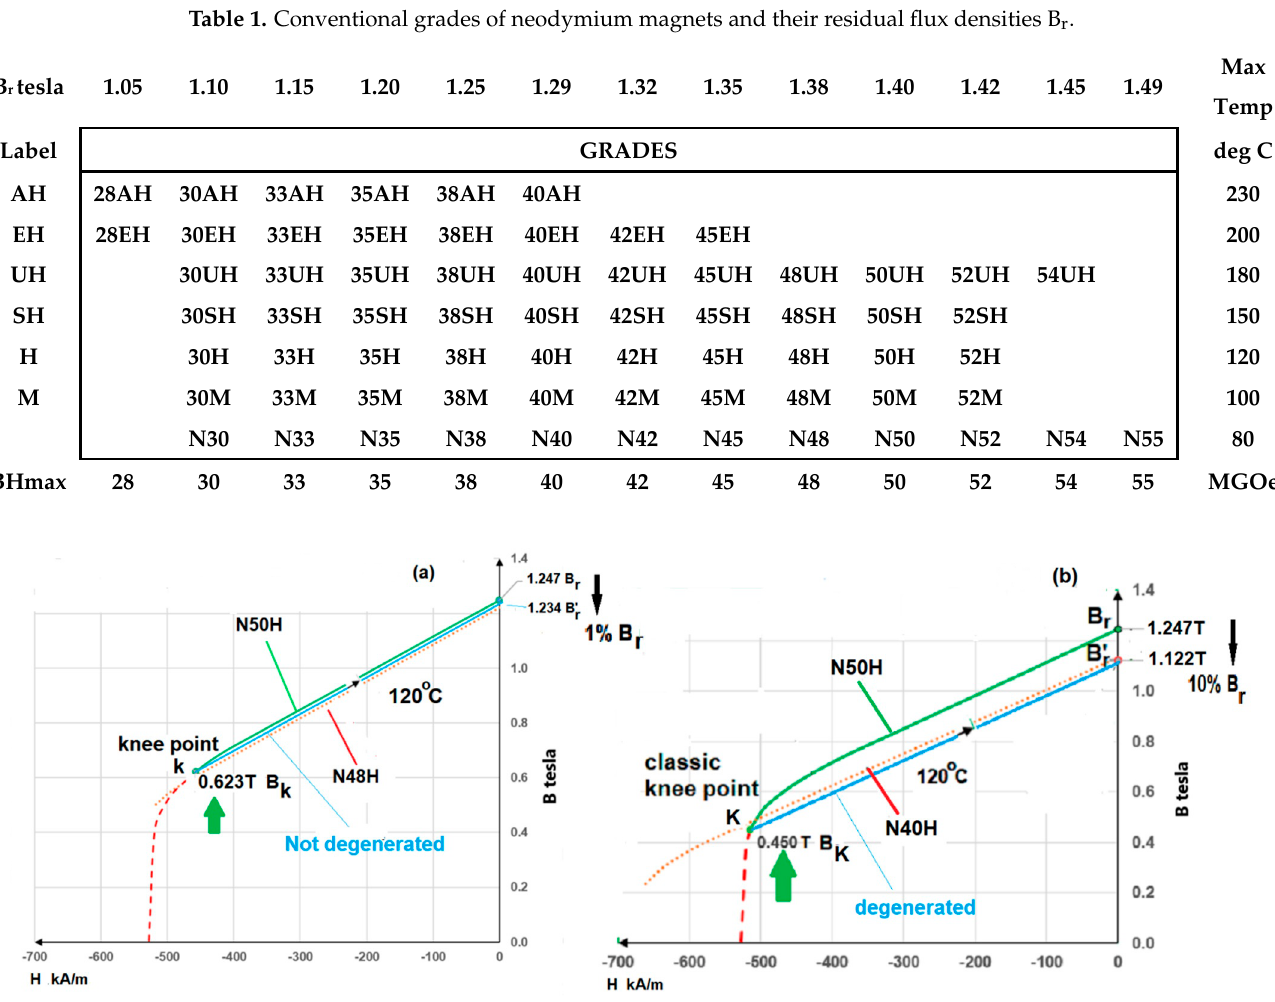
Figure 5. ( a ) The knee point k will not degenerate the magnet to a lower grade. ( b ) The classic knee point K will degenerate the magnet to a four grades lower magnet.